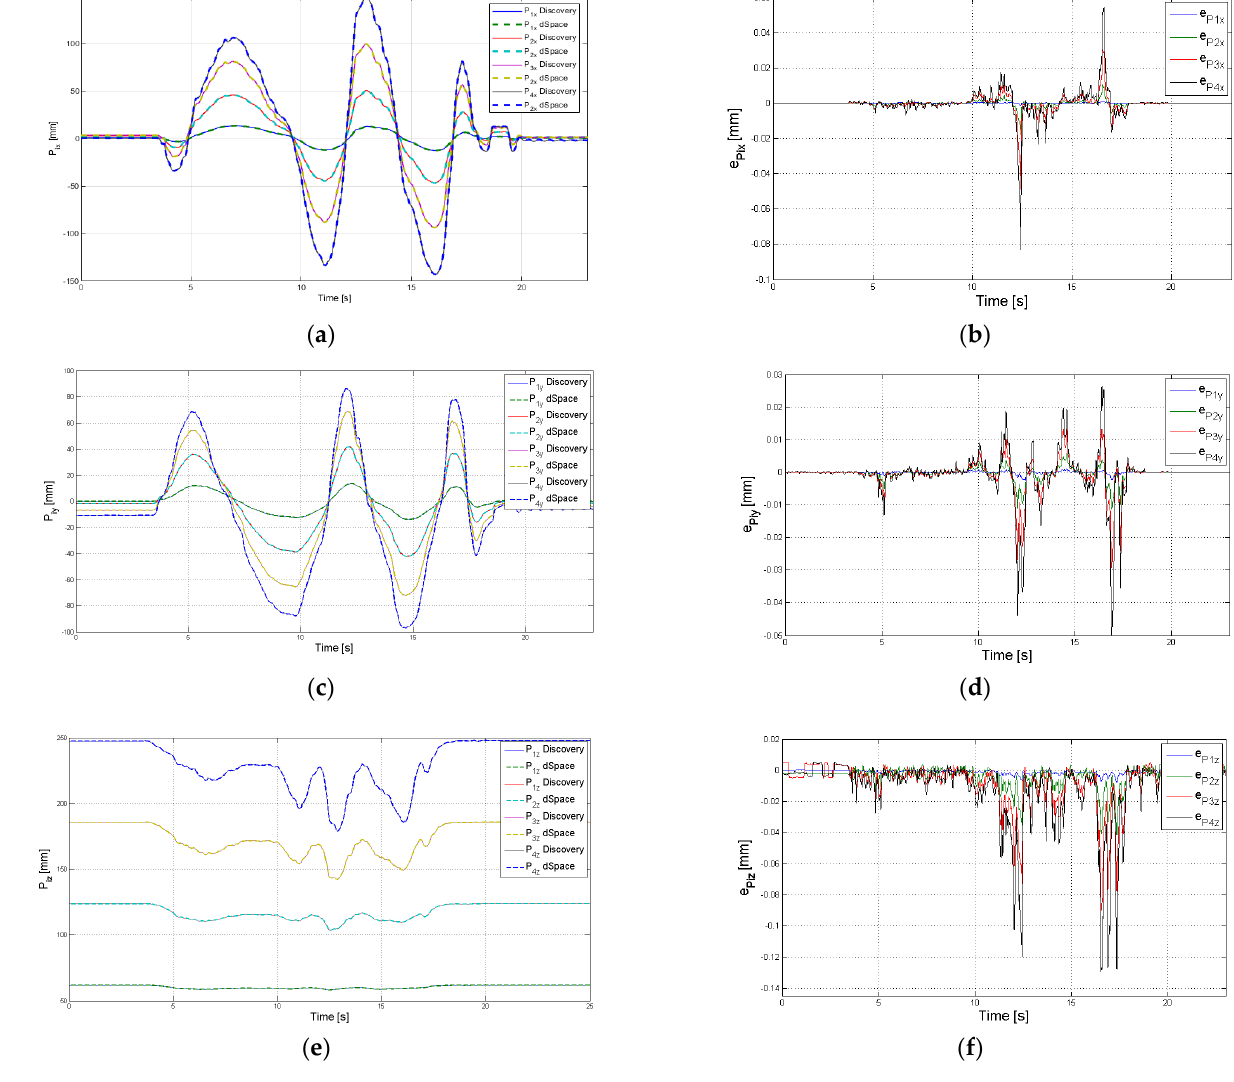
Figure 9. Experimental results for the position of each module of the robot: ( a ) parameters P jx ( b ) absolute error of P jx ( c ) parameters P jy ( d ) absolute error of P jy ( e ) parameters P jz ( f ) absolute error of P jz .